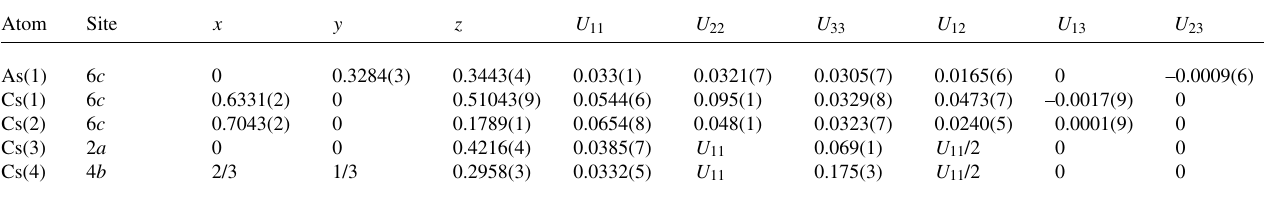
Table 2. Atomic coordinates and displacement parameters (in Å 2 ) .